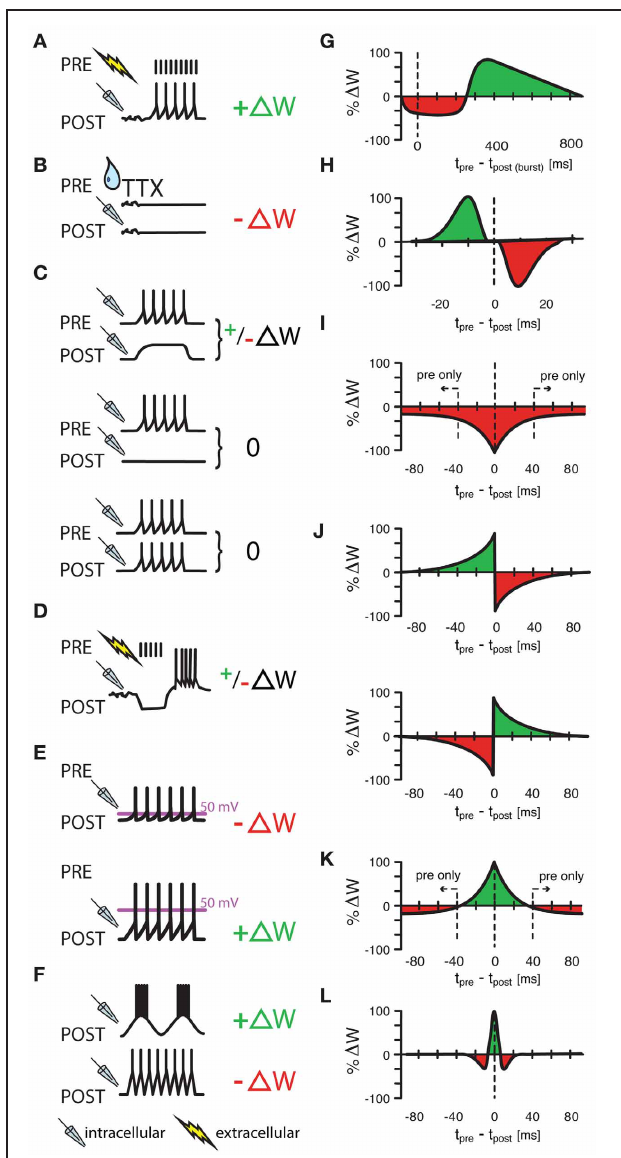
FIGURE 1 | Various protocols of ISP induction. (A) Homeostatic plasticity induced by Hartmann et al. (2008) in > 4 week old mouse CA1 hippocampal slices. A one second long extracellular stimulus of 100Hz, delivered in the presence of glutamatergic and GABA B receptor blockers provoked a strengthening of GABAergic synapses through increased presynaptic GABA concentrations. (B) A similarly homeostatic response was induced by Kilman et al. (2002) in cultures of P3–P5 rat visual cells. Here, 2 day long silencing of the culture with TTX led to decreased amplitude of inhibitory post synaptic potentials (and loss of synapses) that was mediated by a decrease in GABA A receptors. (C) Congruent with (A,B) , Maffei et al. (2006) showed that a postsynaptic depolarization in the presence of presynaptic bursts (20 bursts of ten presynaptic action potentials at 50Hz) strengthens synapses in slices of P21 rat visual cortex with normal activity, but weakens synapses in previously monocularly deprived animals [and thus slices with consequently lower baseline activity and presumably already potentiated inhibitory synapses, (C) , upper panel]. Presynaptic bursts, coupled with postsynaptic silence or firing did not induce any change at all [ (C) , middle and lower panel, respectively]. (D–F) Other